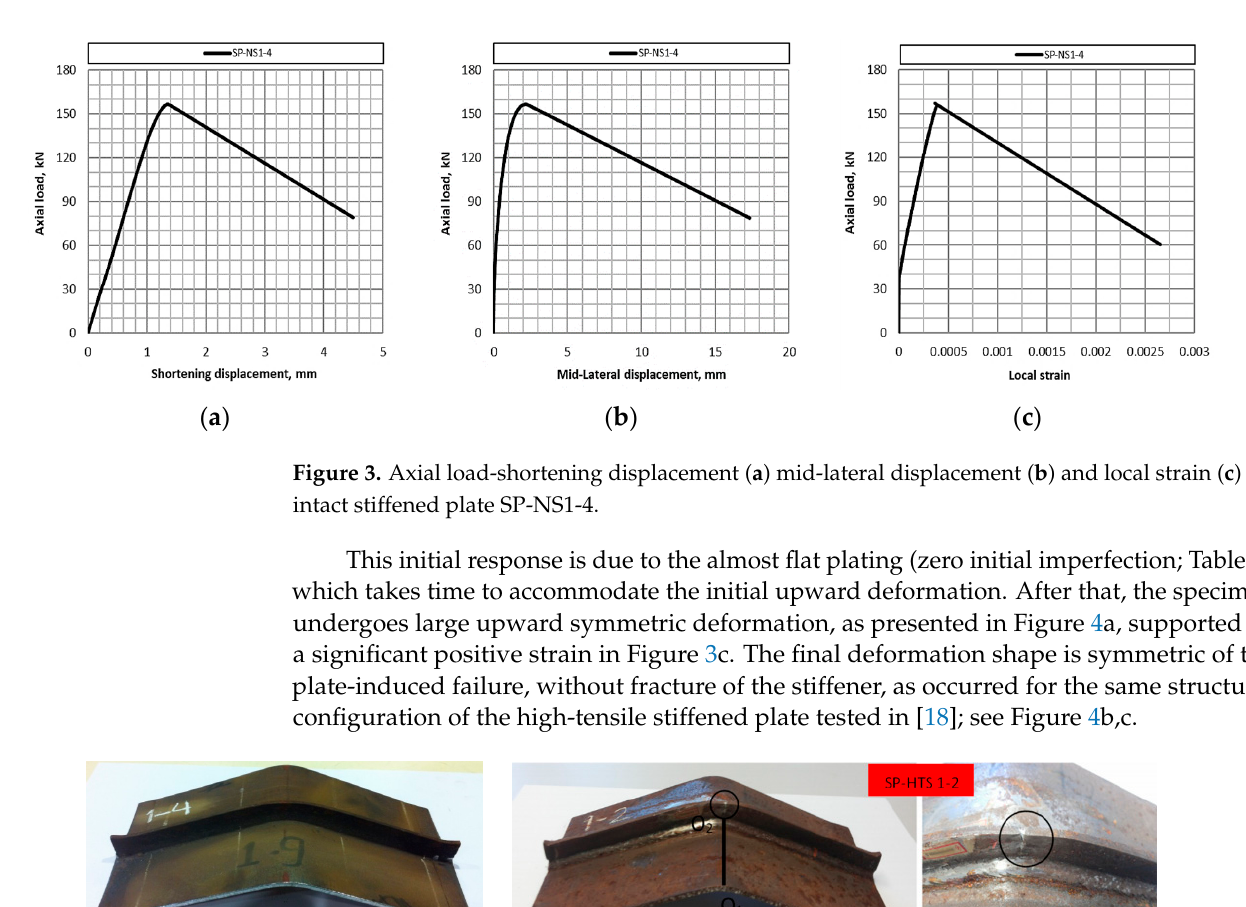
Figure 4. Post-collapse deformed shape for intact stiffened plate SP-NS1-4 ( a ) and SP-HTS1-2 ( b ) and ( c ).